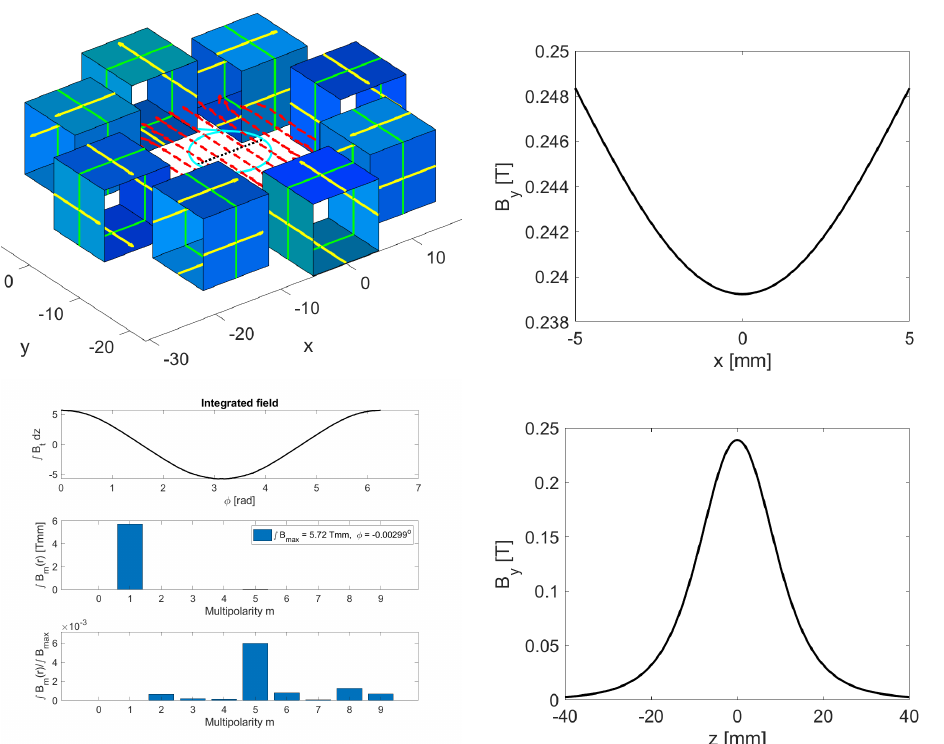
Figure 2. Top left: the eight cubes for a dipole are shown as hollow blue cubes and the magnetic field by red arrows. Top right: the vertical field B y along the black dotted line shown on the top-left image. Bottom right: B y along the axis perpendicular through the center of the ring. Bottom left: the tangential field on the cyan circle (upper panel); the dominant field harmonic, here for a dipole (middle); and the relative strength for the unwanted multipoles